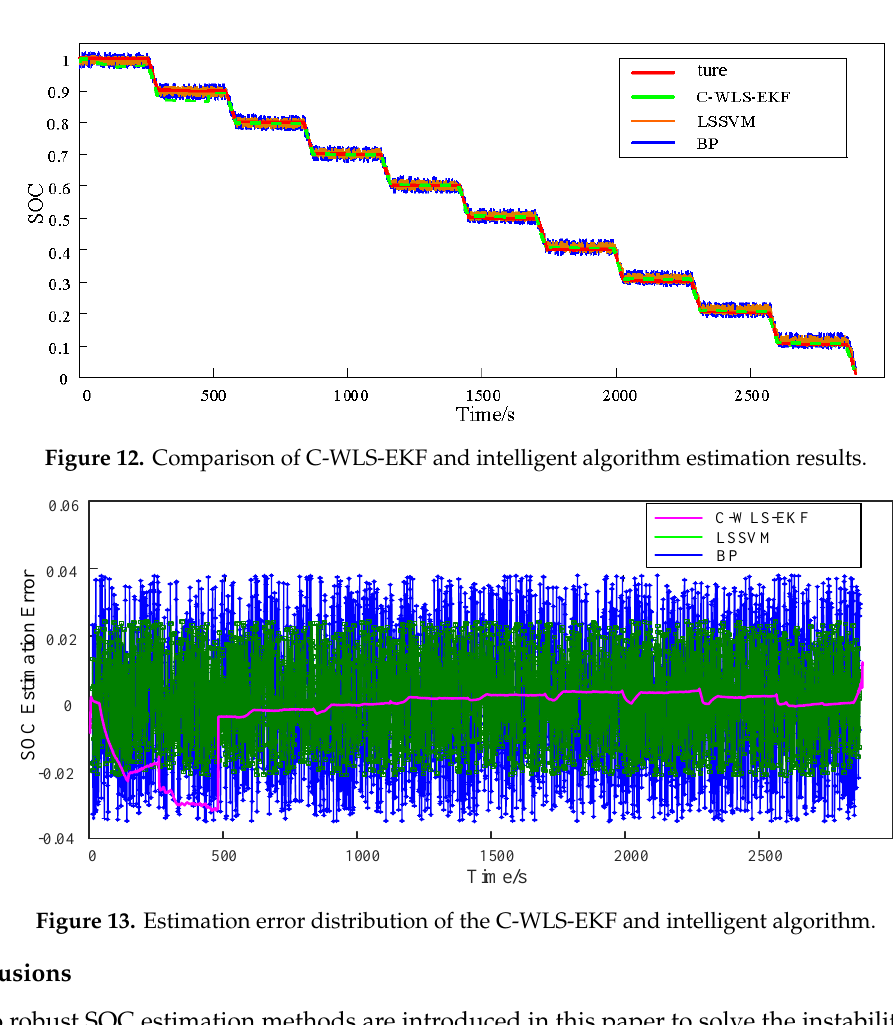
Figure 11. Estimated results under different initial SOCs. Finally, in order to evaluate the performance of the proposed C-WLS-EKF algorithm, we further conduct a comparative experiment with the data-driven methods (least squares support vector machine (LSSVM) and BP neural network). One can see from Figure 12 that the improved C-WLS- EKF algorithm in this paper has much higher accuracy than the intelligent algorithm. After calculation, the estimation errors of SOC using LSSVM and the BP neural network are 1.84% and